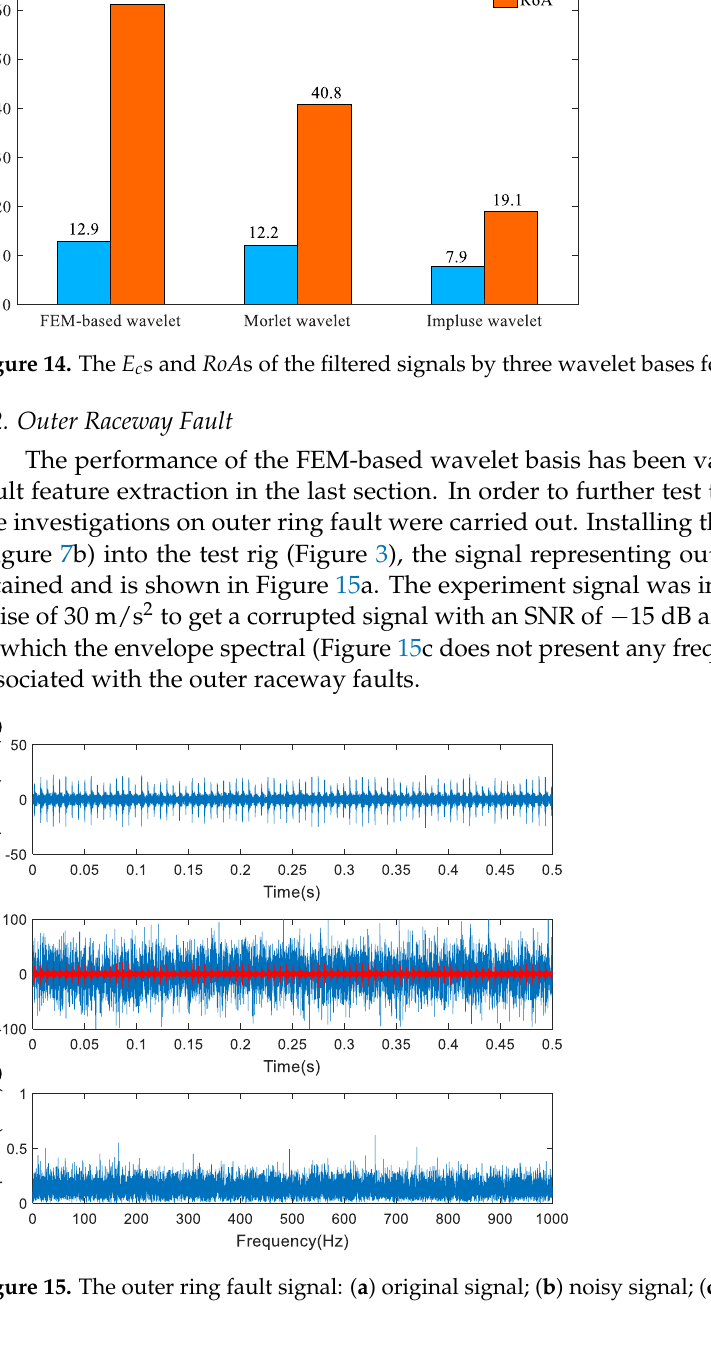
Figure 13. Results of the impulse response wavelet for inner ring fault: ( a ) the filtered signal; ( b ) its envelope spectrum.